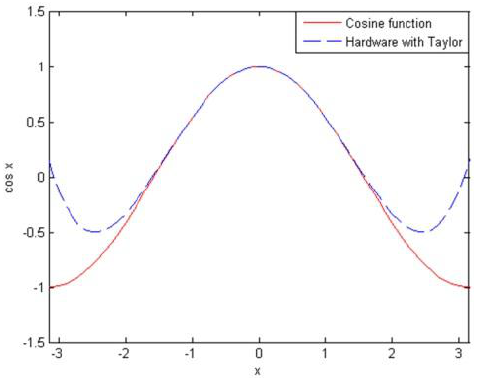
Figure 14. Taylor approximation of the cosine function.